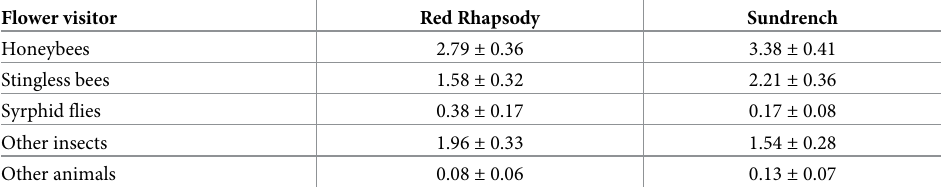
Table 2. Mean ( ± SE) number of flower visitors to strawberry flowers in a 1 m 2 quadrat during a 5-min period on each of four days during peak flowering. Flower visitor